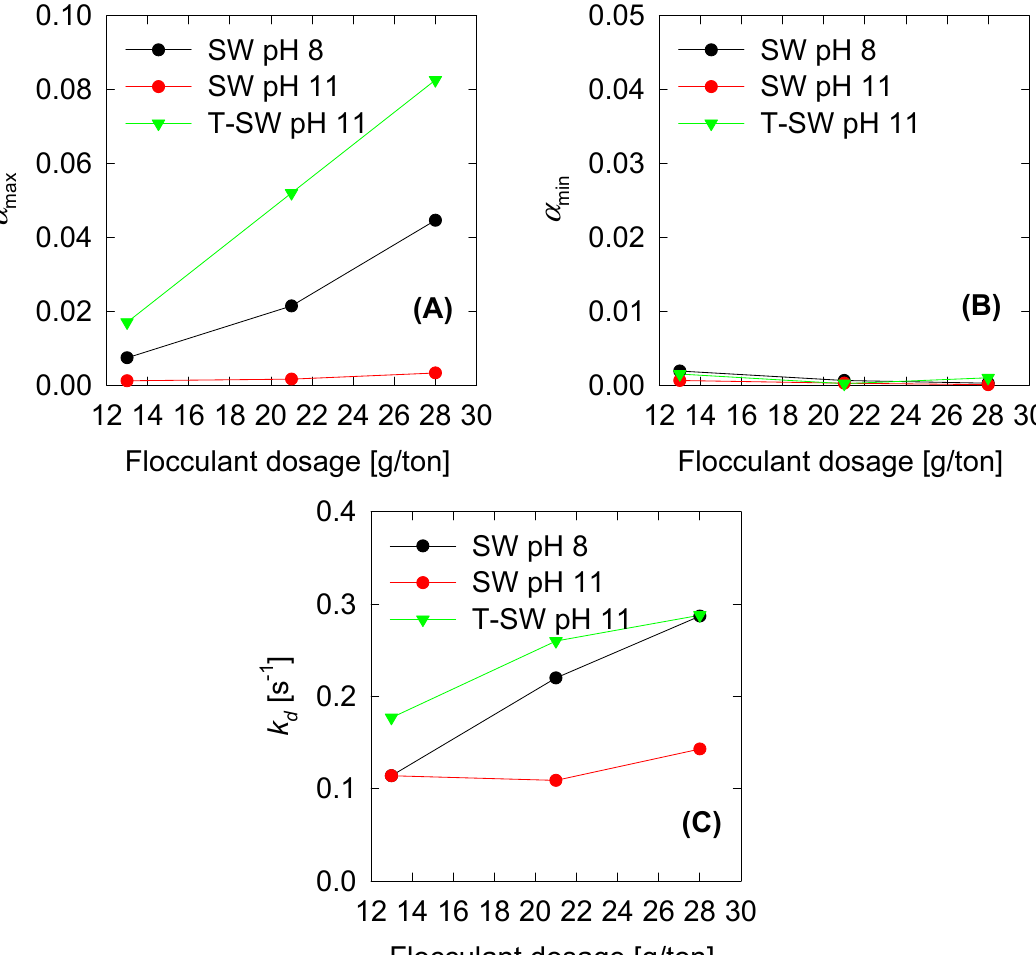
Figure 5. Optimum aggregation parameters vs. shear rate for constant and variable fractal dimension: ( A ) Maximum and ( B ) minimum collision efficiency and ( C ) collision efficiency decay constant k d